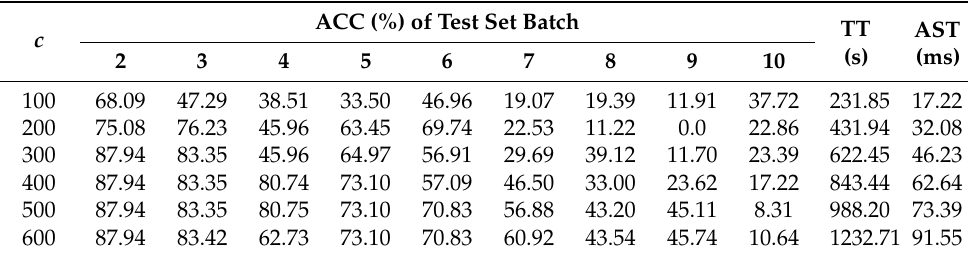
Table 5. Experimental results and average time for